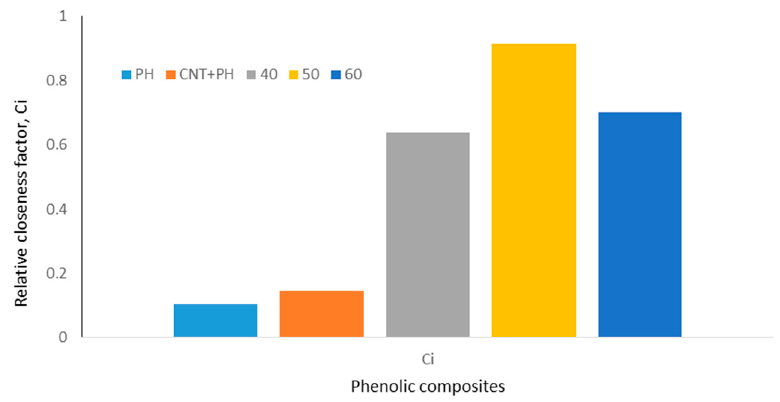
Figure 12. Relative closeness factor of phenolic composites.